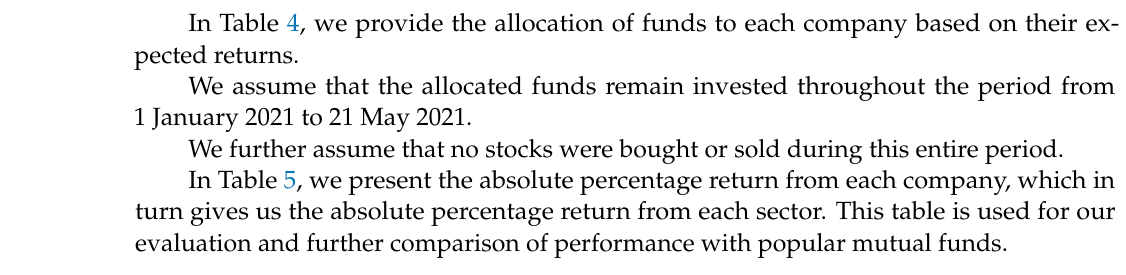
Table 4. Allocation of funds within companies.